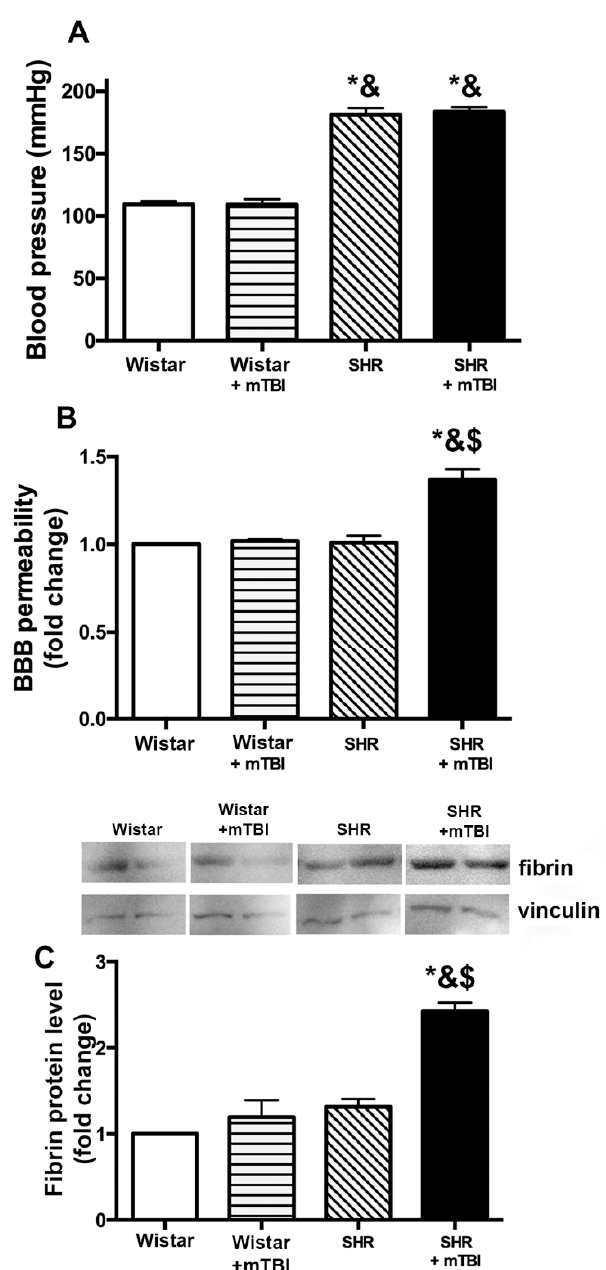
Figure 1. Mild traumatic brain injury (TBI) induces persistent disruption of the blood brain barrier and extravasation of blood borne substances in hypertensive rats. ( A ) shows blood pressure of Wistar rats and spontaneously hypertensive rats (SHR) with and without mild traumatic brain injury (mTBI) measured by the tail-cuff method. Data are means ± S.E.M. ( n = 6 in each group) * p < 0.05 vs. Wistar, & p < 0.05 vs. Wistar + mTBI. ( B ) Summary data show blood brain barrier permeability indicated by extravasated Evans blue content of cerebral tissue (depicted as fold change compared to control) in sham operated Wistar rats and SHRs, and in rats two weeks after mTBI. Data are means ± S.E.M. ( n = 6 in each group) * p < 0.05 vs. Wistar, & p < 0.05 vs. Wistar + mTBI, $ p < 0.05 vs. SHR. ( C ) One representative Western blot presents fibrin level in perfused cerebral tissue from Wistar and spontaneously hypertensive rats (SHR) with and without mild traumatic brain injury (mTBI) (showing two in each group) two weeks after trauma. Summary data depicts cerebral fibrin protein level in cortical tissue of the above groups of animals. Data are means ± S.E.M. ( n = 6 in each group) * p < 0.05 vs. Wistar, & p < 0.05 vs. Wistar + mTBI.